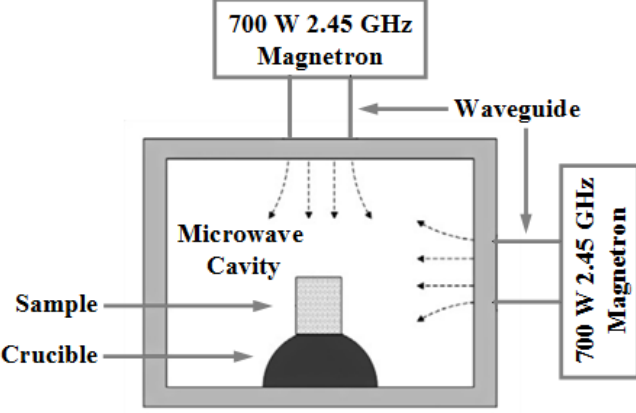
Figure 22. Schematic diagram showing microwave sintering [270]. Reprinted with permission from [270]. Copyright 2013